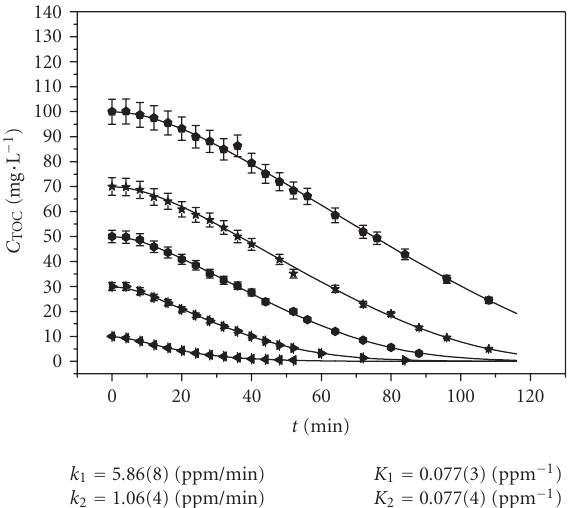
Figure 1: Kinetics of disappearance of 2.4-dichlorophenol (DCP), from its aqueous solutions, in a laboratory-scale photoreactor (see Experimental), with 1.50 W · cm − 1 of absorbed radiation power per unit membrane length, and standard photocatalytic membranes, immobilising 30 wt.% of P-25 titanium dioxide. Concentrations, C in mg/L (ppm; mass/volume), for DCP, are expressed as carbon, which was not transformed into intermediates, as a function of time t , expressed in minutes. In the figure, the four optimised parameters, k 1 and K 1 , k 2 and K 2 , obtained by kinetic modelling, are also reported, together with the probable error, shown between parentheses, as uncertainty in the last digit.